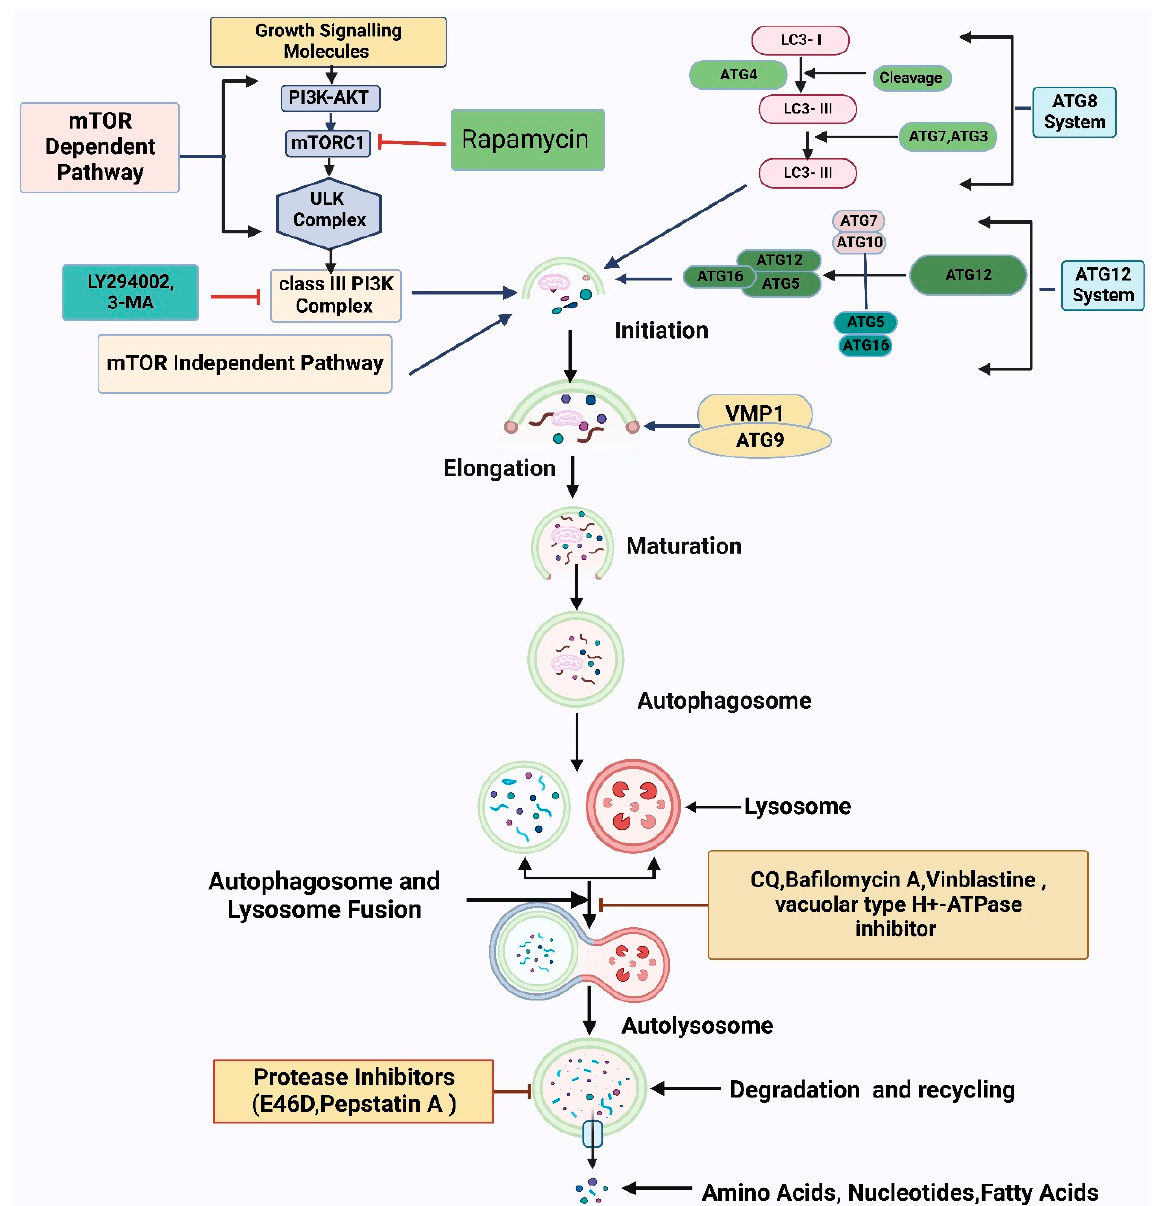
Figure 1. The autophagy pathway’s biological role and its underlying molecular mechanism. The autophagy process starts when the action of several proteins creates a structure called a pre-autophagosome. The interaction of the ULK1/VPS34/beclin-1 complex impacts phosphoinositide 3-kinase (PI3K)-AKT and the mammalian target of rapamycin (mTOR) to begin pre-autophagosome assembly. Additionally, the ATG5/ATG12/ATG16 and ATG12/ATG5/LC3 complexes are involved in causing phagophore nucleation and the accumulation of elongated macromolecules, in addition to their ability to bind to the developing autophagosomes. With the assistance of the ESCRT/SNARE/RAB7 protein complex, lysosomes can attach to mature autophagosomes, ultimately leading to autolysosome production. Finally, acid hydrolases successfully dismantle autolysosomes, liberating metabolites and nutrients.